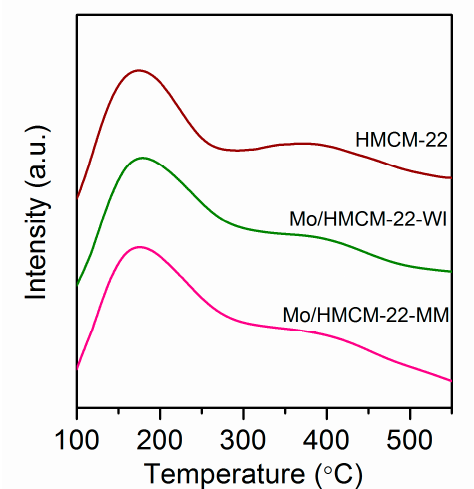
Figure 5. H 2 -TPR profiles for the Mo/HMCM-22-HS, Mo/HMCM-22-WI and Mo/HMCM-22-MM catalysts.